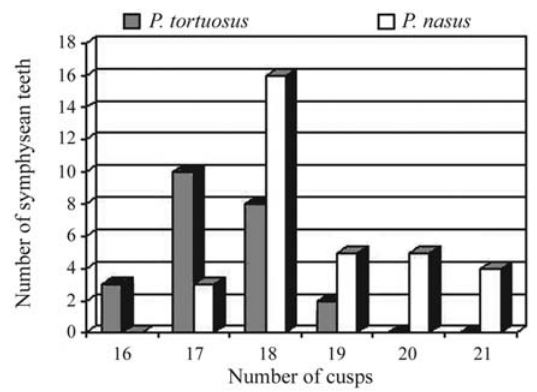
Figure 5 - Histogram showing the distribution of frequency of cusps by teeth in P. tortuosus (grey) and in P. nasus